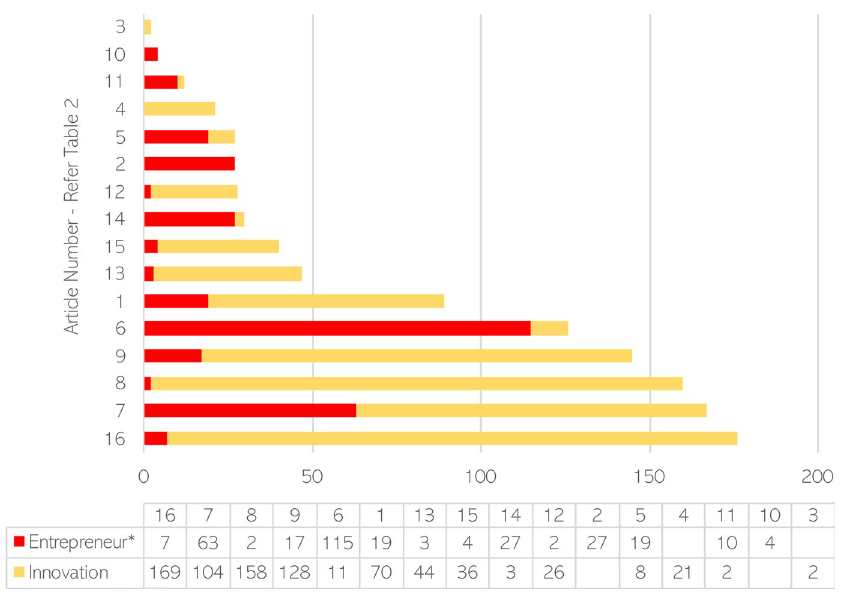
Fig. 10 Occurrences of Search